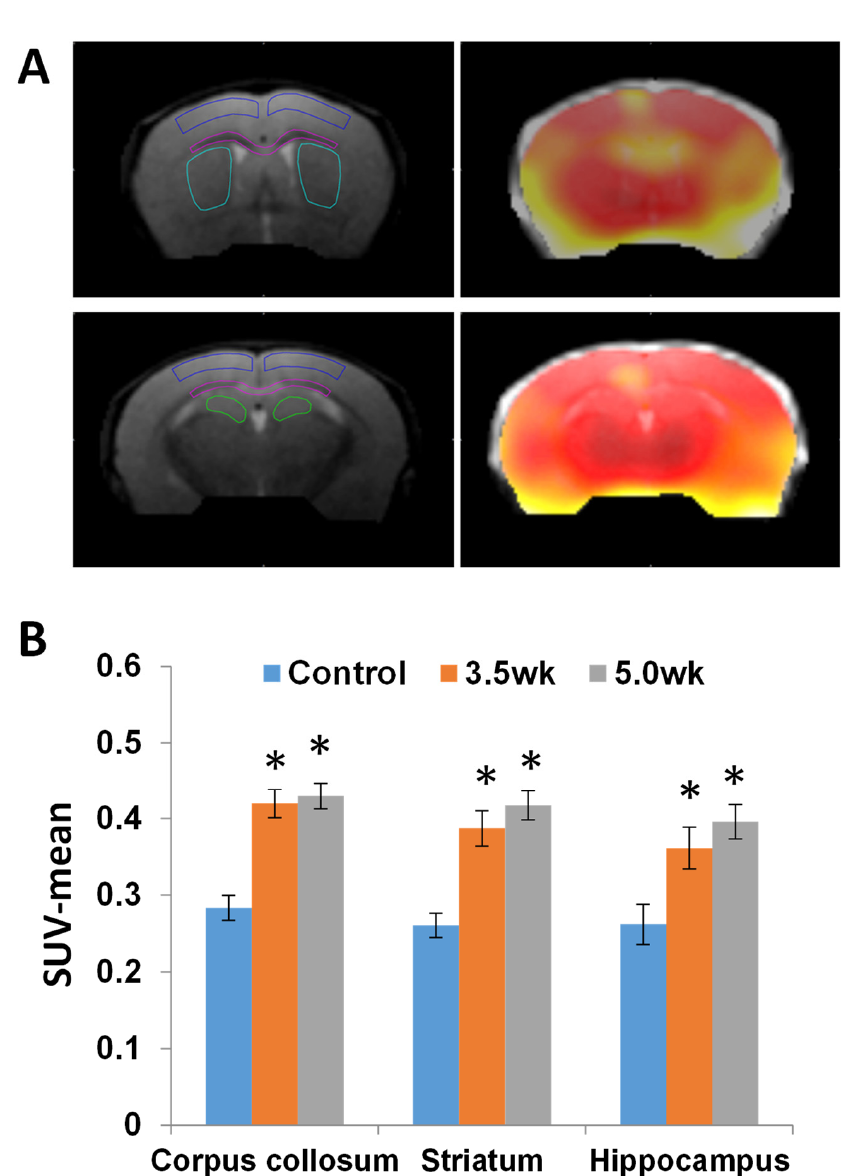
Figure 4 . Quantification of the 18 F-PBR-111 in PET images acquired at 40 min post injection. PET images were registered to the corresponding T2w MR images ( A ). Regions of Interest (ROIs) of cortex (dark blue), corpus callosum (magenta), striatum (caudate/internal capsule, teal/light blue), and hippocampus (green) were drawn in the T2w MRI (left) and superimposed to the PET images (right). There were significant increases (*, p < 0.05) of 18 F-PBR-111 uptake in the corpus callosum, striatum, and hippocampus in 3.5 and 5.0-weeks CF mice compared to the control mice ( B ). No significant differences were detected between the 3.5-weeks and 5.0-weeks groups on the bar graph in the corpus callosum, striatum or hippocampal regions. There was however a trend of increased uptake in all three regions from 3.5 to 5 weeks.